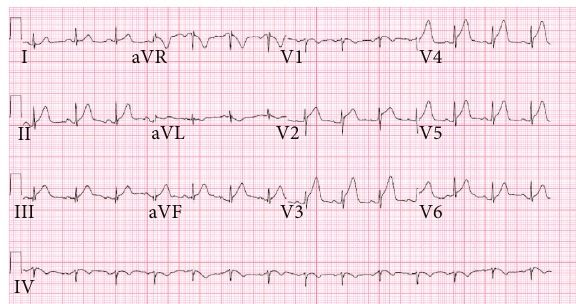
Figure 1: Presenting EKG showing inferior-lateral ST segment elevation.